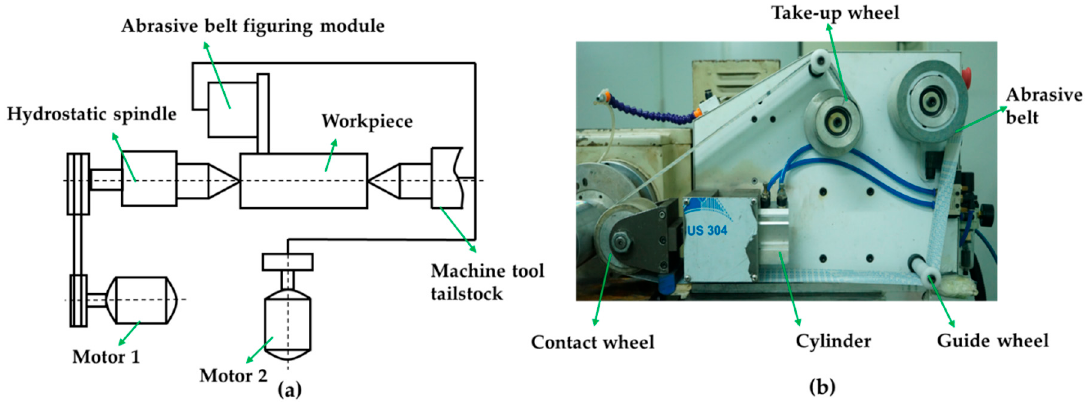
Figure 5. Figuring experimental device: ( a ) Schematic diagram of abrasive belt-based figuring system; ( b ) composition of the abrasive belt-based figuring module.